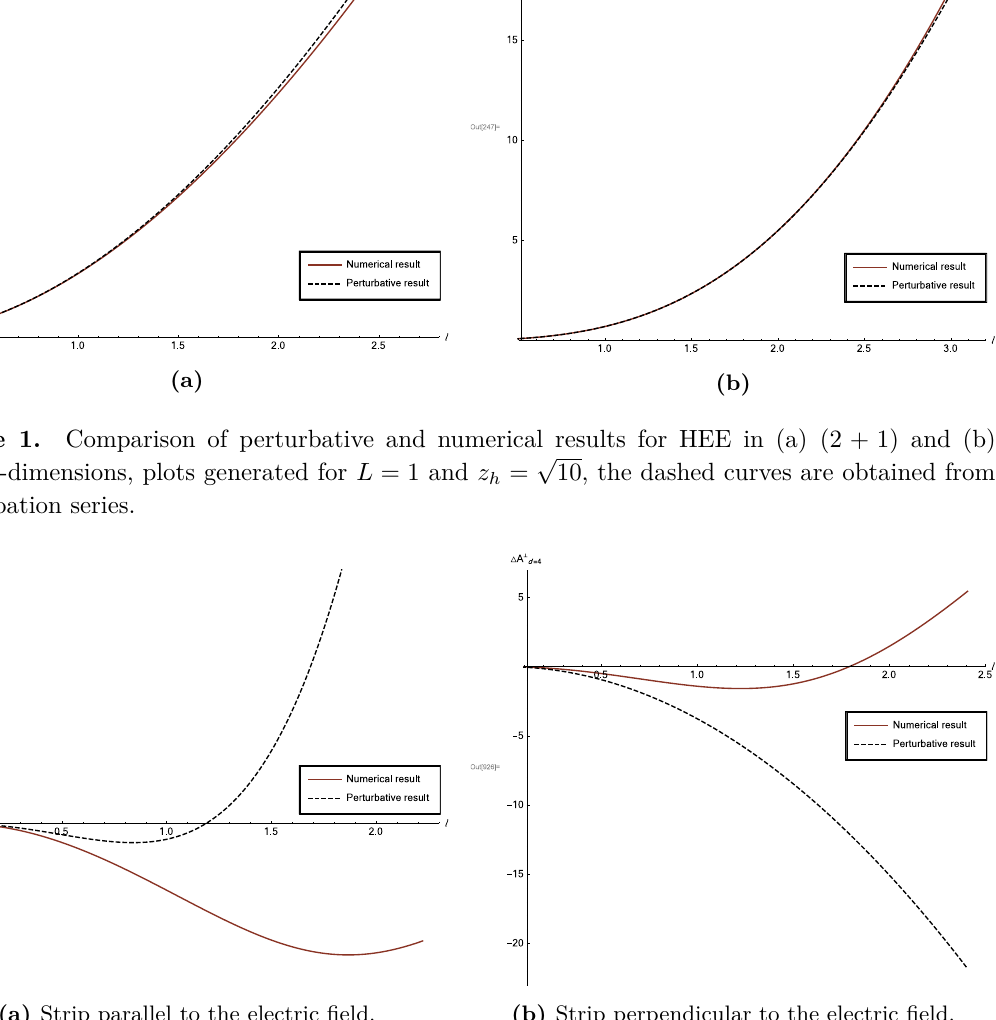
Figure 2. Comparison of perturbative and numerical results for HEE in (4 + 1) dimensions, plots √ generated for L = 1 and z h = 10 , the dashed curves are obtained from perturbation